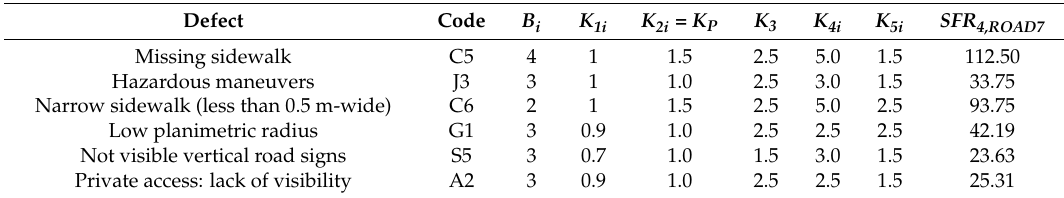
Table 9. Input data for BIR 4,ROAD7 calculation.